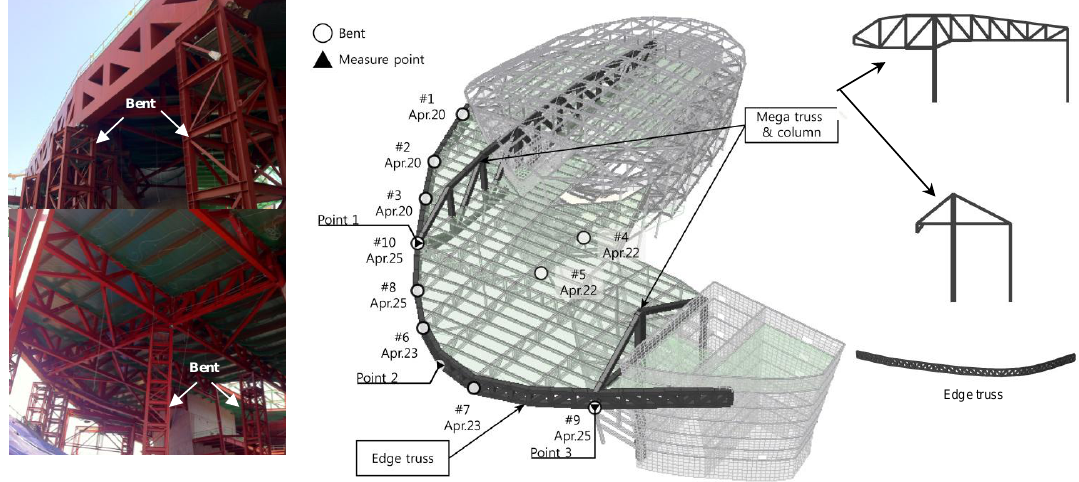
Figure 5. Target structure (building